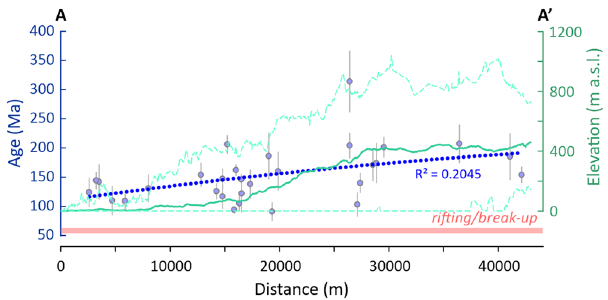
Fig. 5 AHe data as a function of distance from the passive margin. Mean AHe dates and their 2 σ uncertainties along the swath pro fi le A-A ’ in Fig. 2 plotted as a function of distance from a simpli fi ed coastline indicated in Fig. 2. Maximum, mean, and minimum elevation (green curves) are calculated from cross-sections sampled approximately every 1.5 km. The data show an ill-de fi ned trend with mean AHe dates younging towards the coast as indicated by the 2 nd order polynomial function trendline with weak correlation. All mean AHe dates predate the timing of Paleocene rifting and